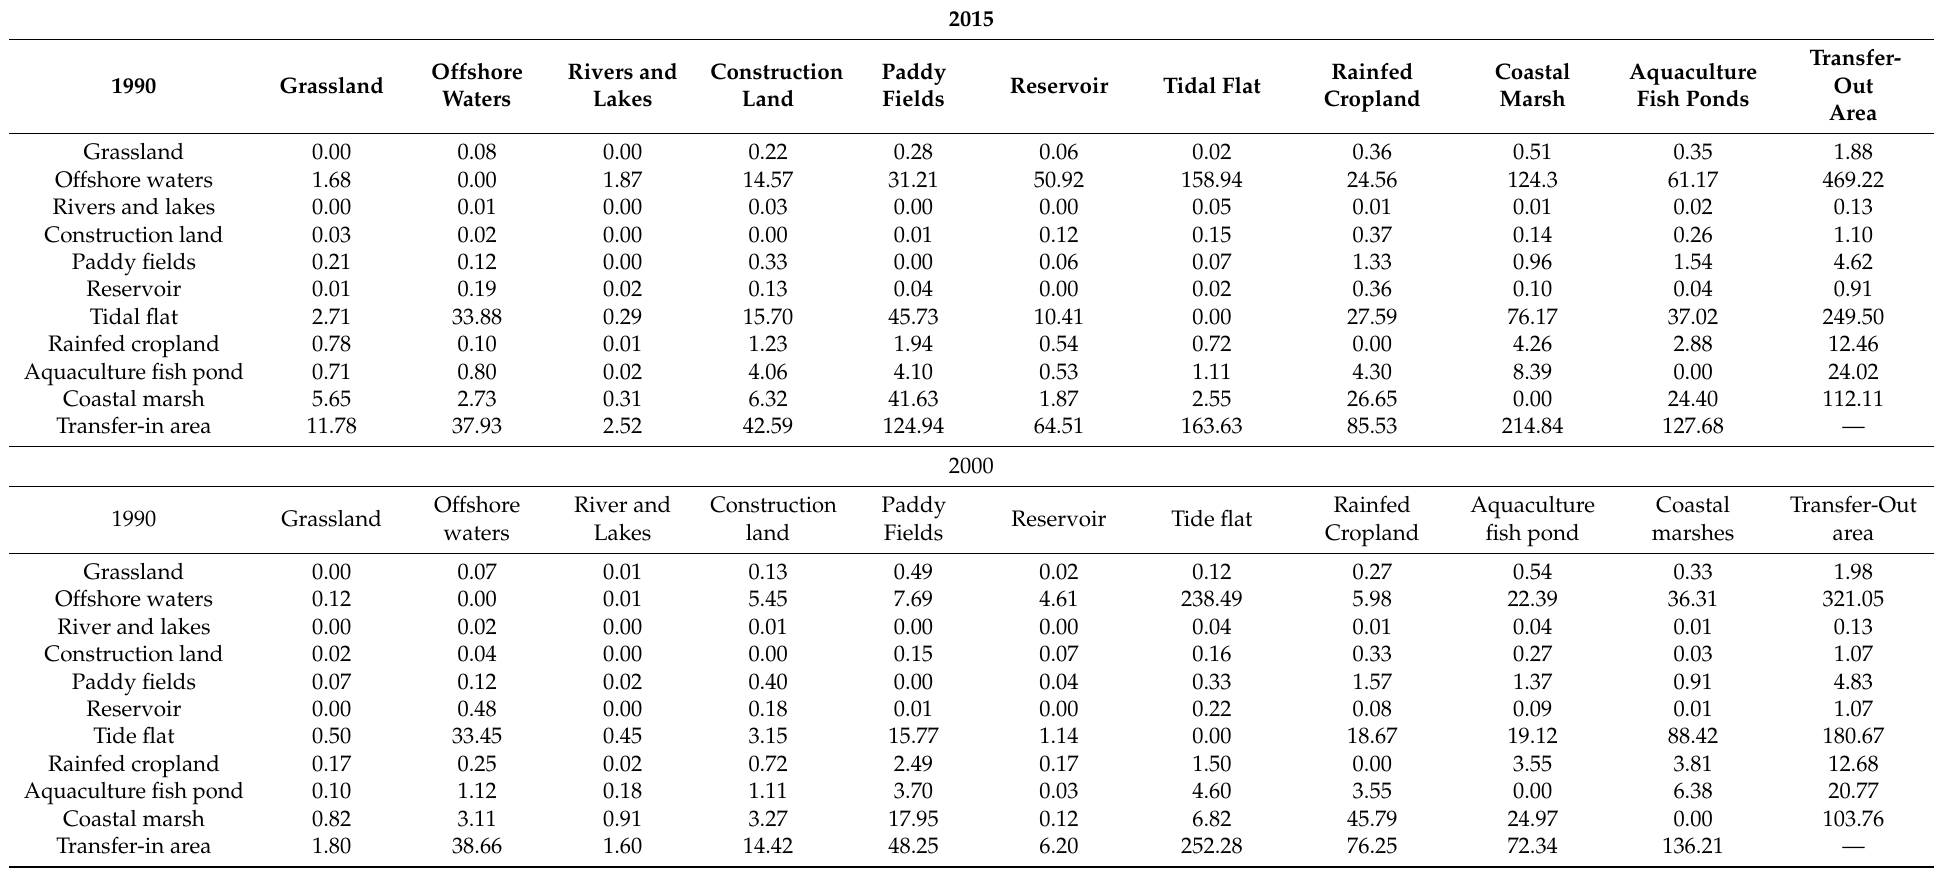
Table 4. The land use/land cover transition matrix of the Shanghai coastal area (unit: km 2